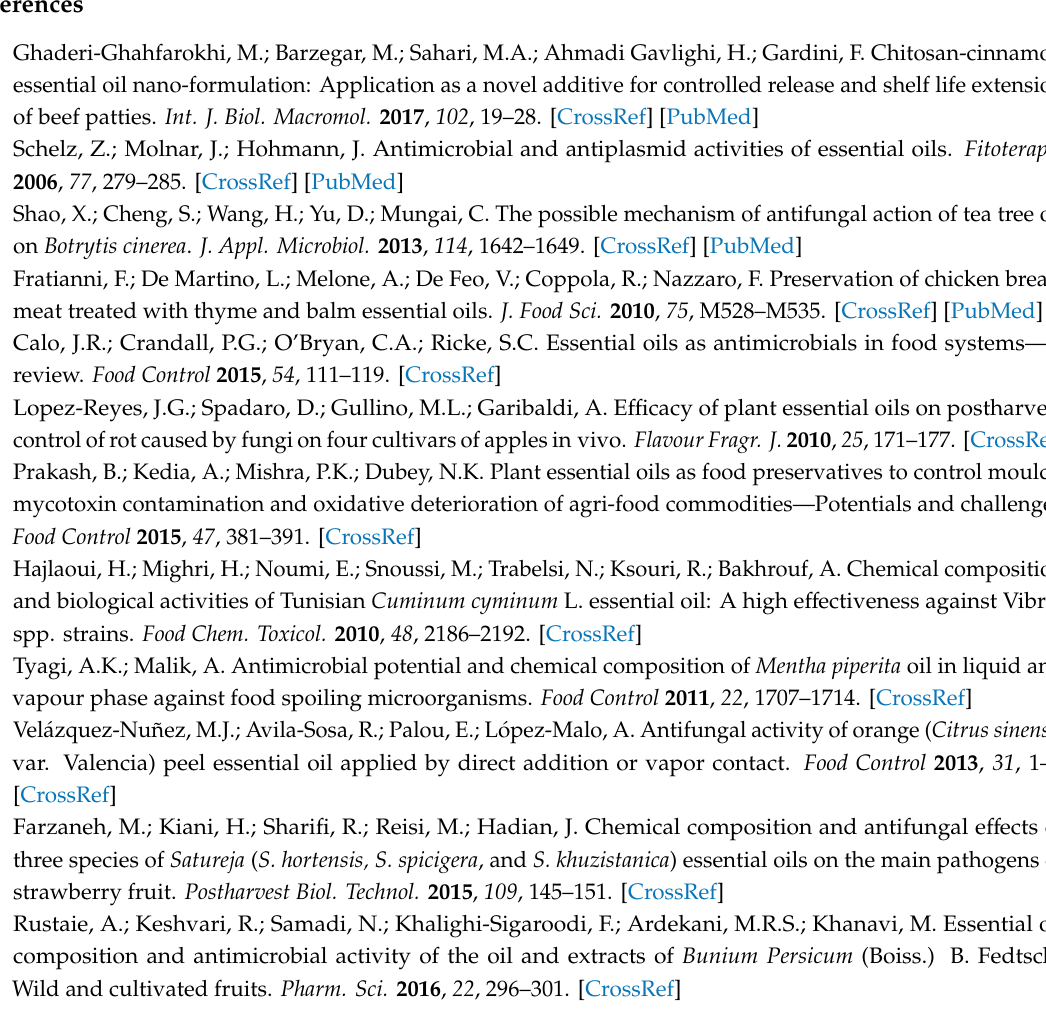
Table S1: Antimicrobial activities of essential oils of the main functional foods in both liquid and gas phases. References [58–87] are cited in the supplementary